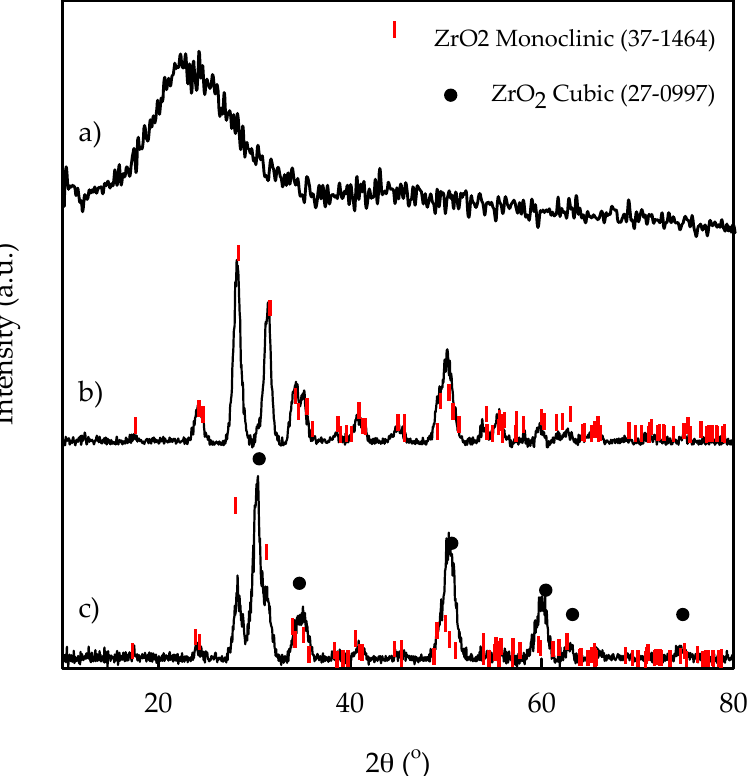
Figure 1. Wide-angle X-ray diffractograms of the synthesized ZrO 2 materials: ( a ) ZrO 2 /Si-SBA 15, ( b ) ZrO 2 (m) and ( c ) ZrO 2 (m+c).